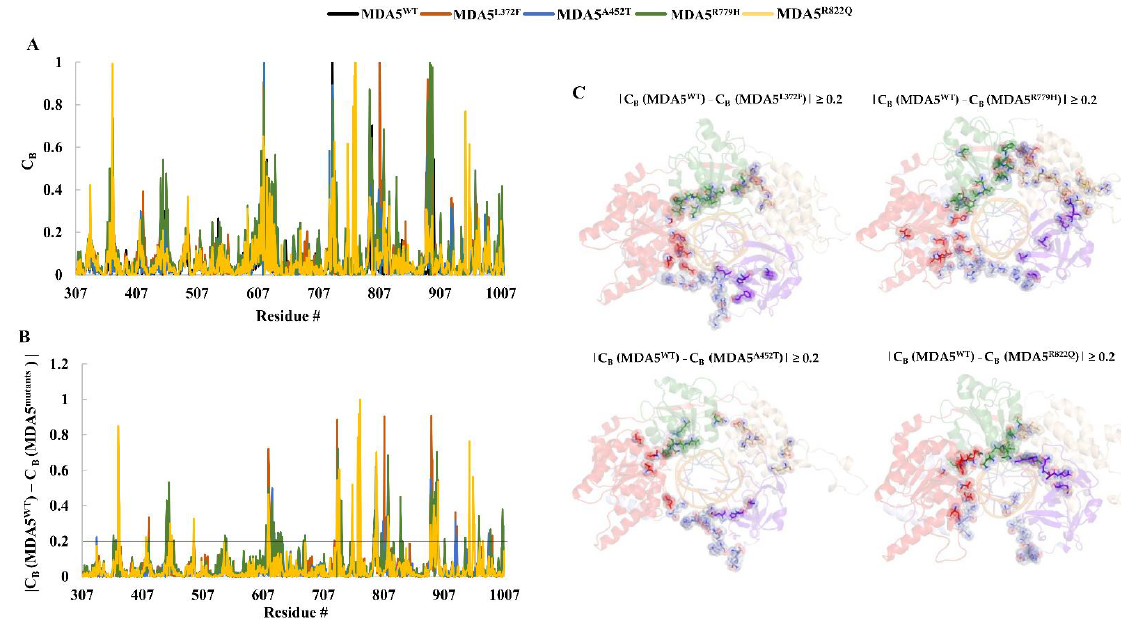
Figure 6. Betweenness centrality (C B ) analysis. C B values were calculated for each complex using the representative structures. ( A ) The plot represents the C B of each complex. ( B ) The plot represents the difference in C B of MDA5 wild type and mutants based on the condition |C B MDA5 WT − C B MDA5 mutants | ≥ 0.2 (absolute values). ( C ) The selected residues are mapped on the MDA5 and its variant structures. The residues are color coded as per the colors represented in Figure 1B. Table 3. The table represents the residue numbers from MDA5 mutants for which the C Bd between MDA5 wild-type and mutants is 0.2 or more. Bold type distinguishes the residues common for two or more mutants.